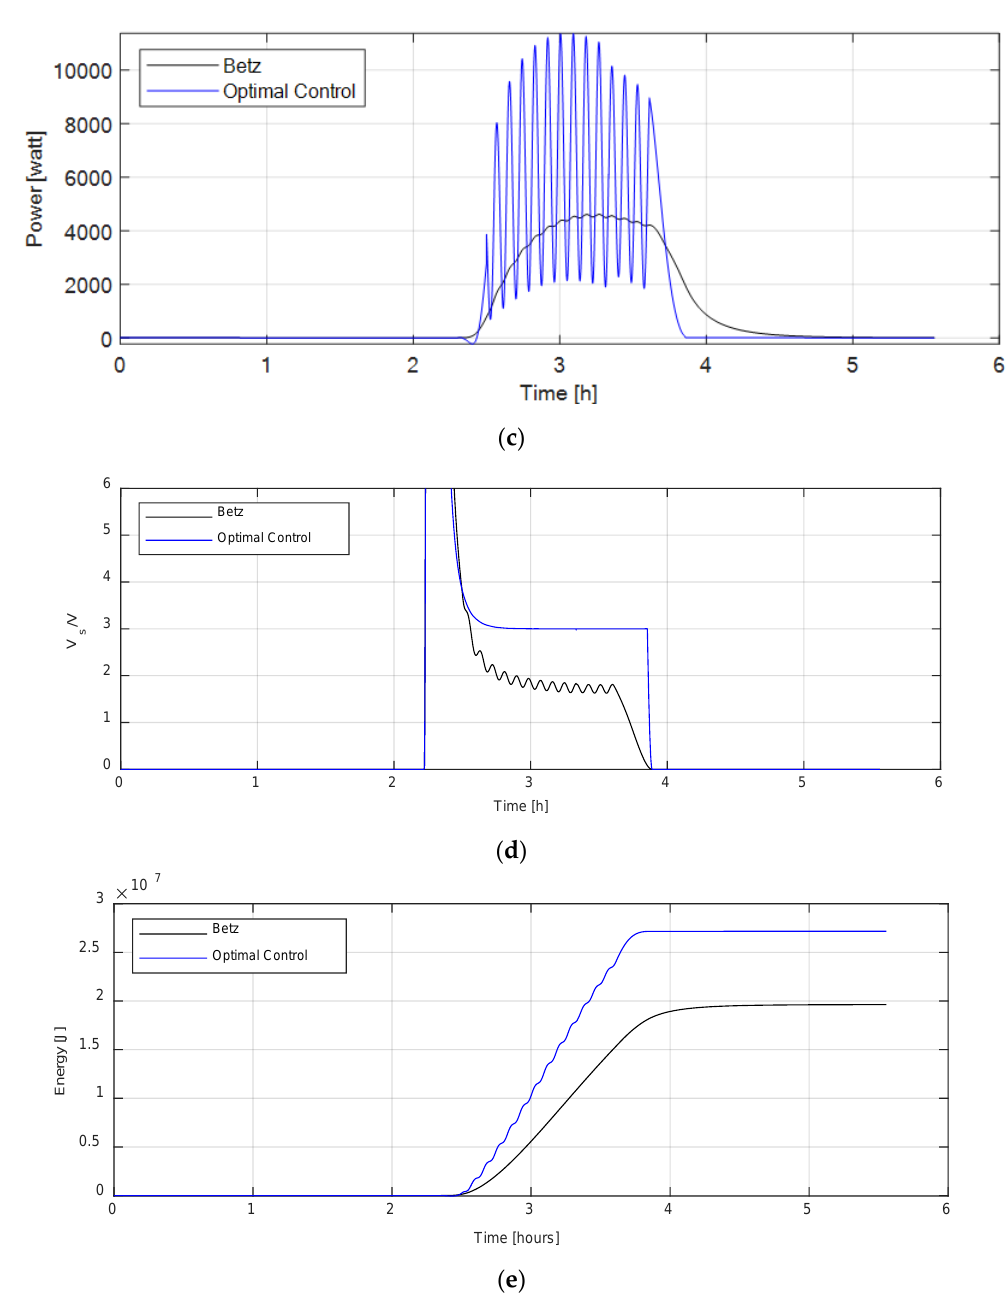
Figure 7. Comparison between the OCBM optimal control and Steady wind turbine for a wind gust: ( a ) the trend of the wind speed; ( b ) the wind speed power spectral density (PSD); ( c ) the instant power, ( d ) the speed ratio; ( e ) the energy storage.